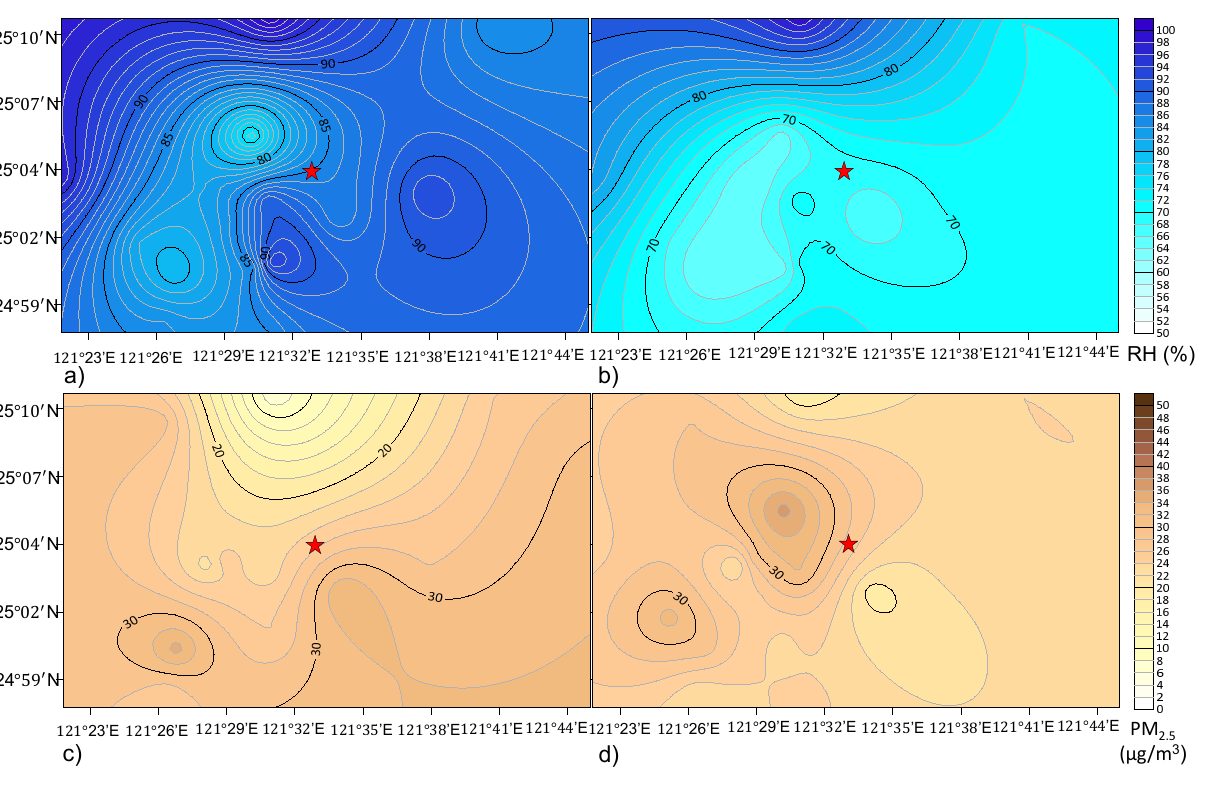
Figure 7. Comparison of the distributions of relative humidity (RH) and PM 2.5 concentrations between the two cases when the synoptic weather pattern was type I and the urban heat island effect was greater than 0 °C: ( a , c ) mean PM 2.5 concentration was 25.9 µg/m 3 , and mean RH was 84.7% on 24 February 2016 14:00 LST; ( b , d ) mean PM 2.5 concentration was 25.9 µg/m 3 , and mean RH was 68% on 14 March 2016 14:00 LST. The red star symbol indicates Songsang International Airport (121° 33 ′ 09 ″ E, 25° 04 ′ 11 ″ N).